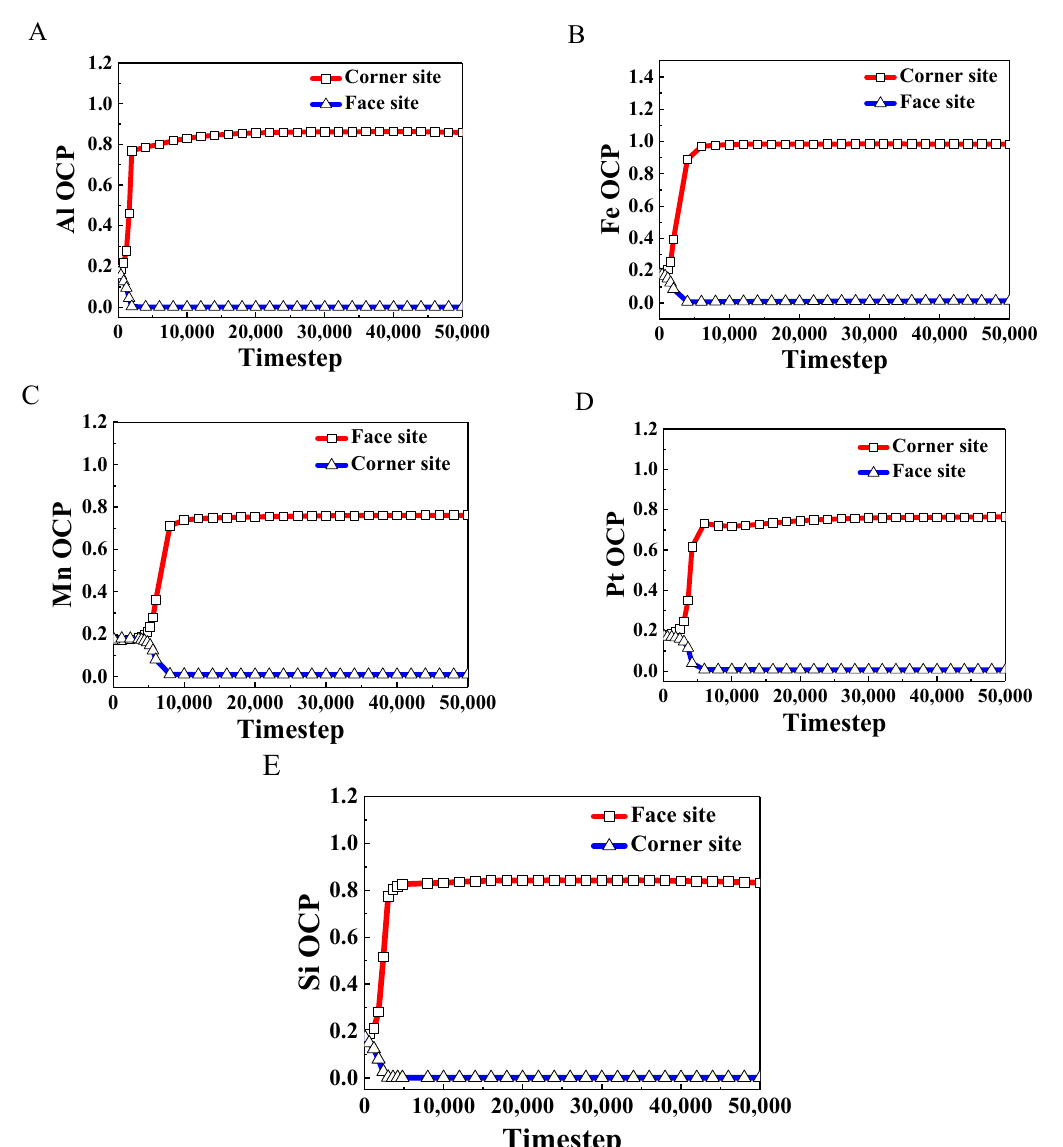
Figure 6. Occupancy probabilities (OCP) of solute atoms for: ( A ) Al; ( B ) Fe; ( C ) Mn; ( D ) Pt; ( E ) Si at corner and face sites as a function of timestep.